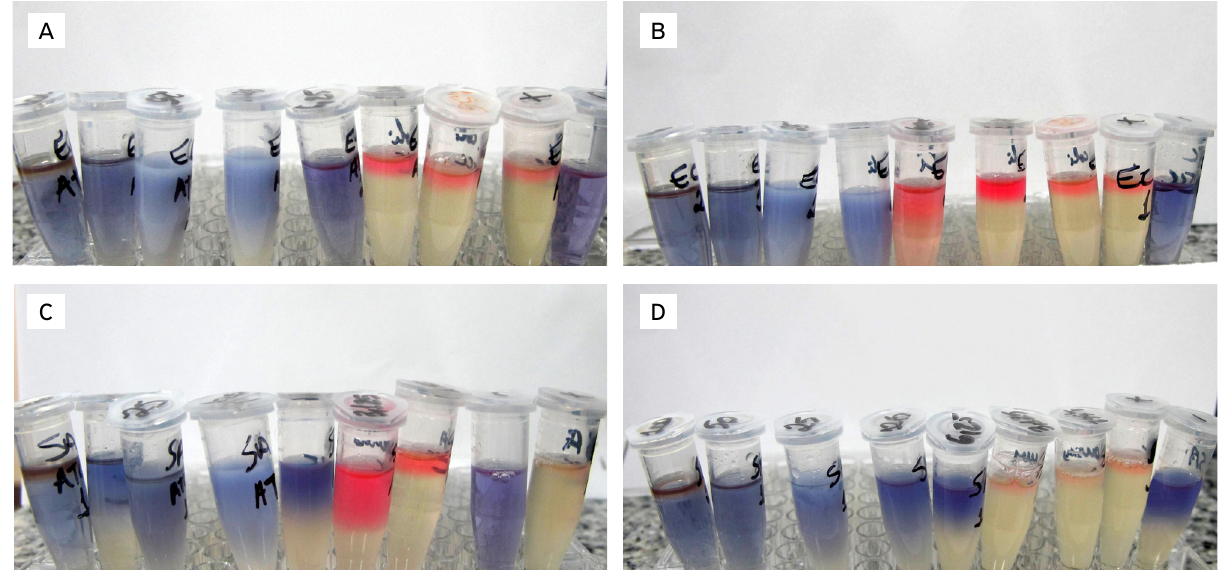
Figura 2. Microtubos usados no experimento de macrodiluição após uma hora da adição de resazurina sódica. (A) E. coli ATCC, (B) E. coli clínica, (C) S. aureus ATCC e (D) S. aureus